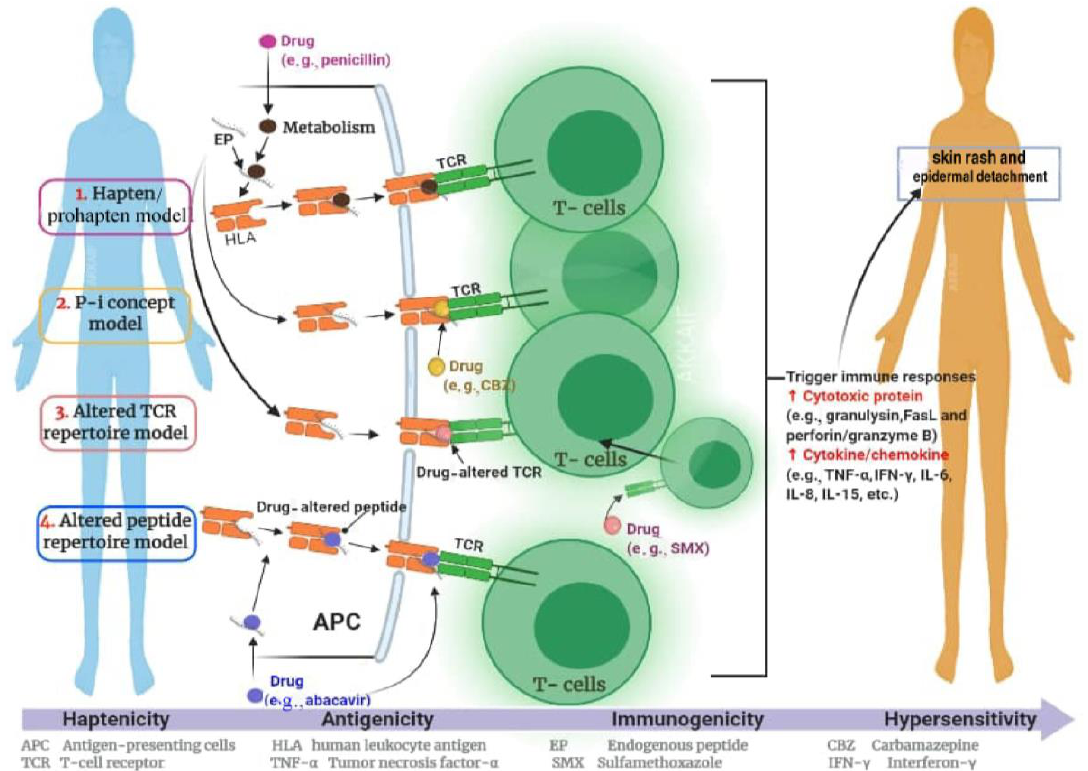
Figure 2. The hypothesis pertaining to the immune response mechanism during severe cutaneous adverse reaction.